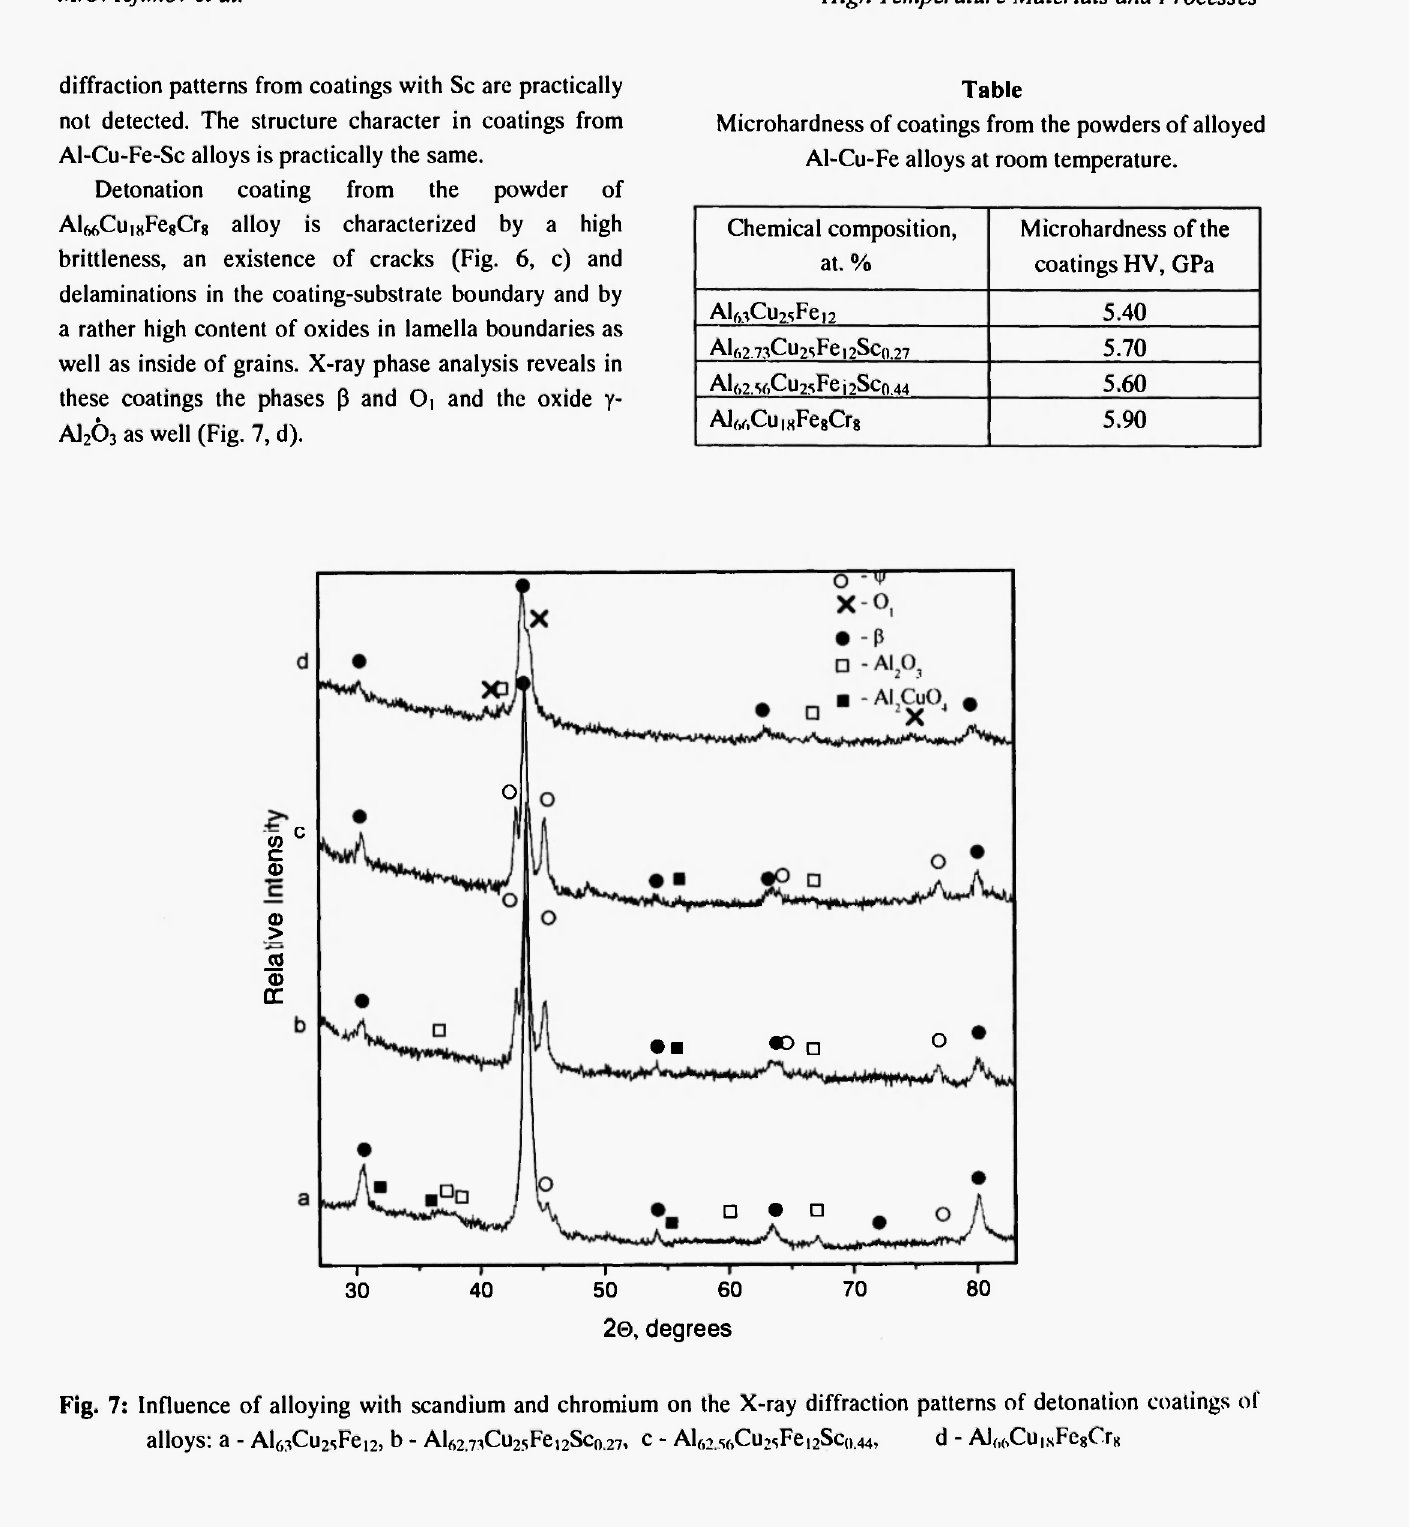
Microhardness of coatings from the powders of alloyed Al-Cu-Fe alloys at room temperature.